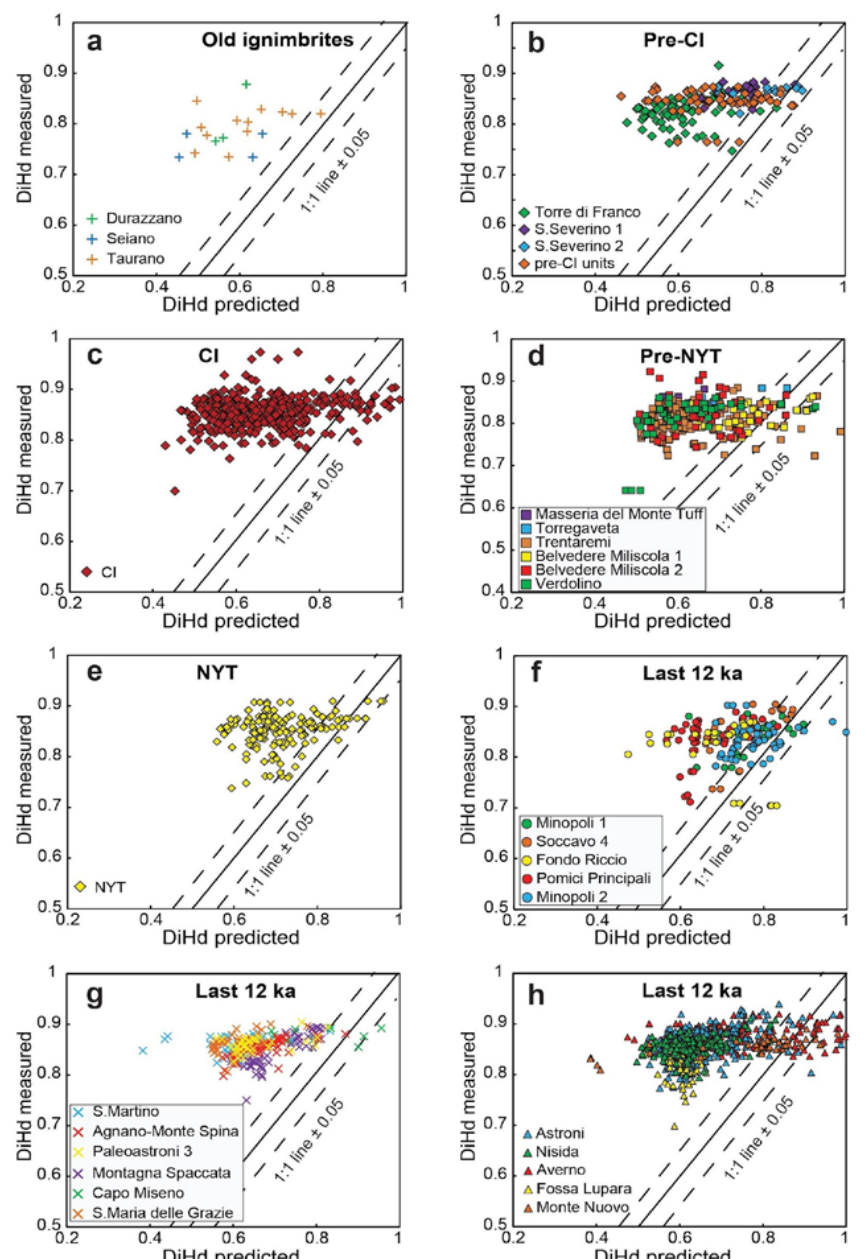
Figure 8. Equilibrium test 2 based on the comparison between measured and predicted clinopyroxene components, i.e., Di + Hd between crystal and melt from equilibrium values [126] for Campi Flegrei products belonging to Old ignimbrites ( a ), Pre-CI ( b ), CI ( c ), Pre-NYT ( d ), NYT ( e ) and last 12 ka ( f – h ).